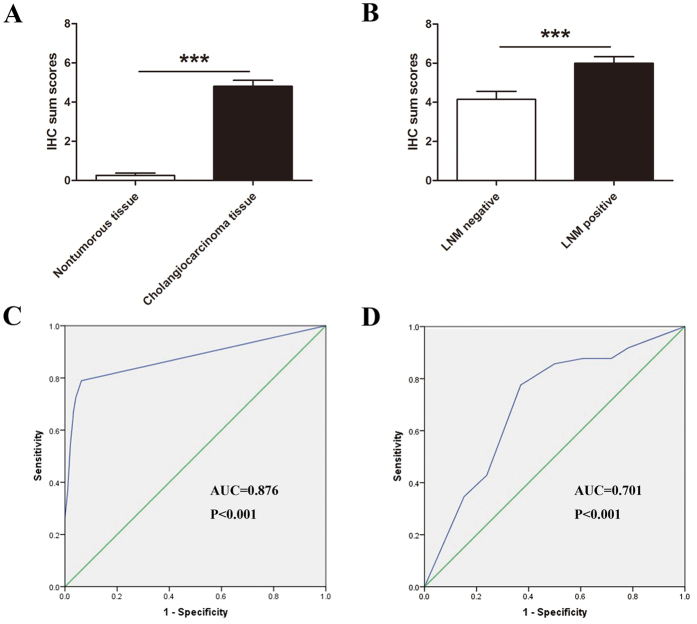
Upregulation of β6 in more aggressive cholangiocarcinoma tissues and ROC curves to assess the diagnostic value of β6 expression in cholangiocarcinoma.IHC sum scores were used to assess integrin β6 expression in cholangiocarcinoma tissues and adjacent non-tumorous tissues. β6 expression was significantly upregulated in cholangiocarcinoma tissues compared to adjacent non-tumorous tissues. (A) β6 expression was markedly higher in cholangiocarcinoma tissues with lymph node metastasis than those without lymph node metastasis. (B) The ROC curves showed strong separation between cholangiocarcinoma tissues and adjacent non-tumorous tissues, with an AUC of 0.989 (P < 0.001). (C) The ROC curves showed strong separation between the patients with and without lymph node metastasis, with an AUC of 0.741 (P < 0.001). ***P < 0.001.